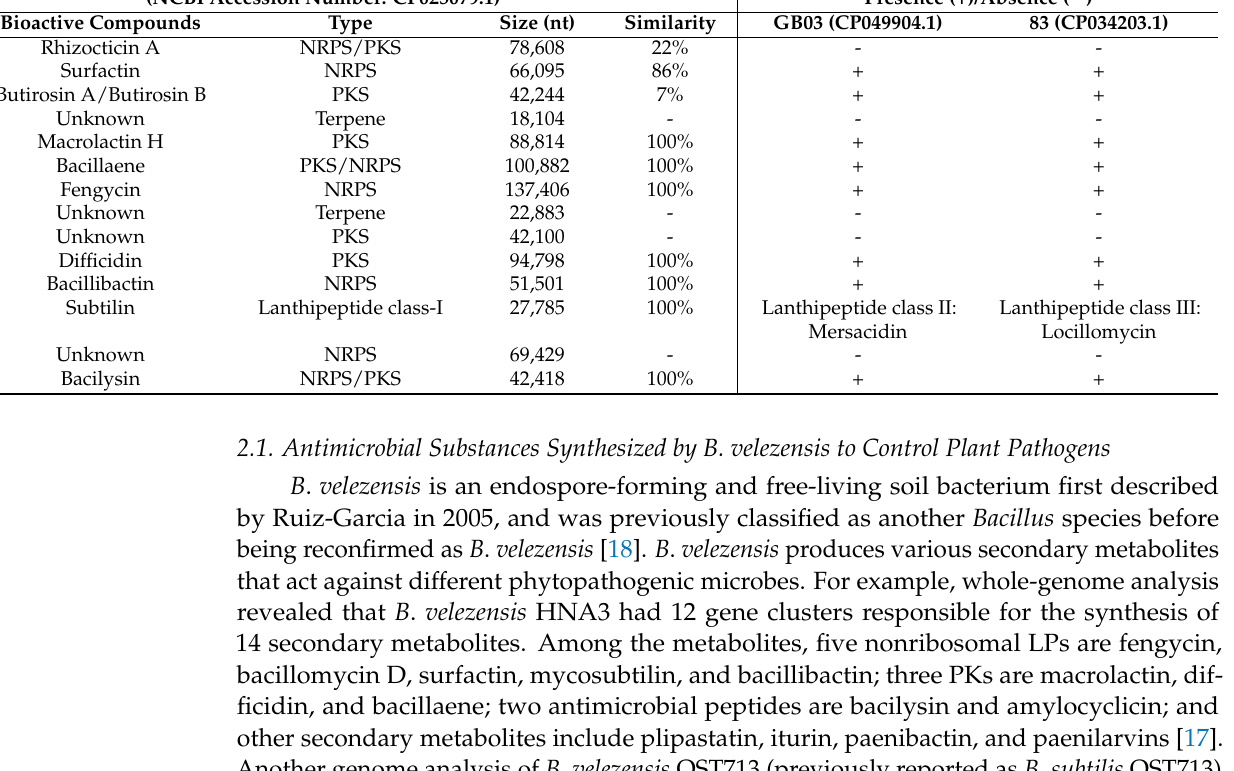
Table 1. Comparison of gene clusters encoding antimicrobial compounds in several commercial B. velezensis -based biocontrol agents. The gene clusters in B. velezensis QST71 (Serenade ® ) are compared with the genomes of B. velezensis GB03 (Kodiak TM) and B. velezensis 83 (Fungifree AB™). Gene Clusters of B . velezensis QST713 (NCBI Accession Number: CP025079.1)